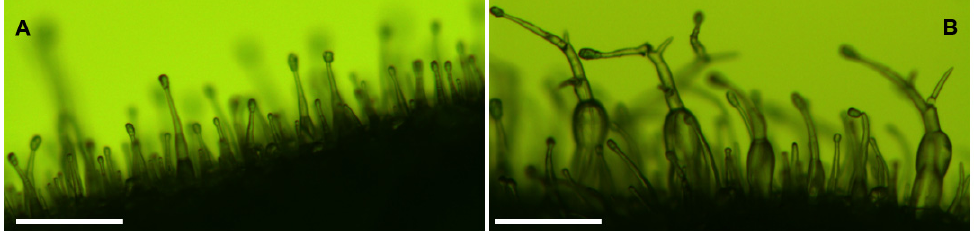
Figure 3. Trichomes on wt ( A ) and transgenic ( B ) tobacco leaf edges visualized using a dissection microscope. Samples were viewed at 38 × magnification. It is noticeable that the base of some trichomes has become enlarged and trichomes are exhibiting novel branching in the transgenic line ( B ). Scale bars: 200 μ m.